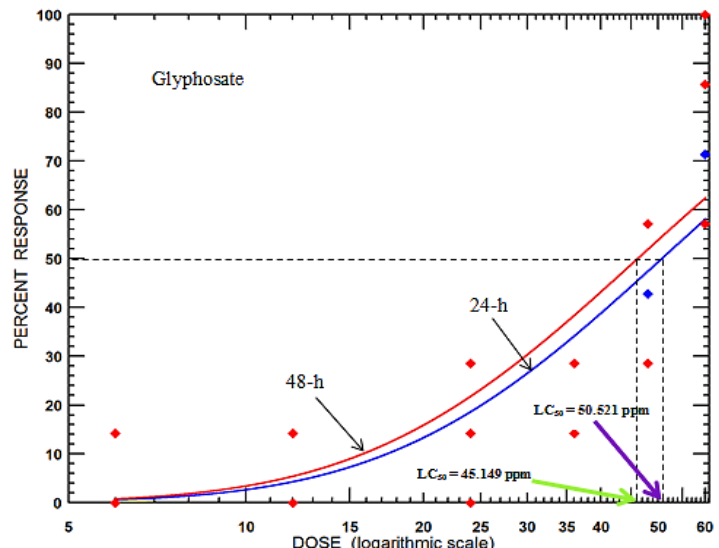
Figure 4. Acute lethal concentrations (24 and 48 h) of cypermethrin and glyphosate to Eucypris sp.